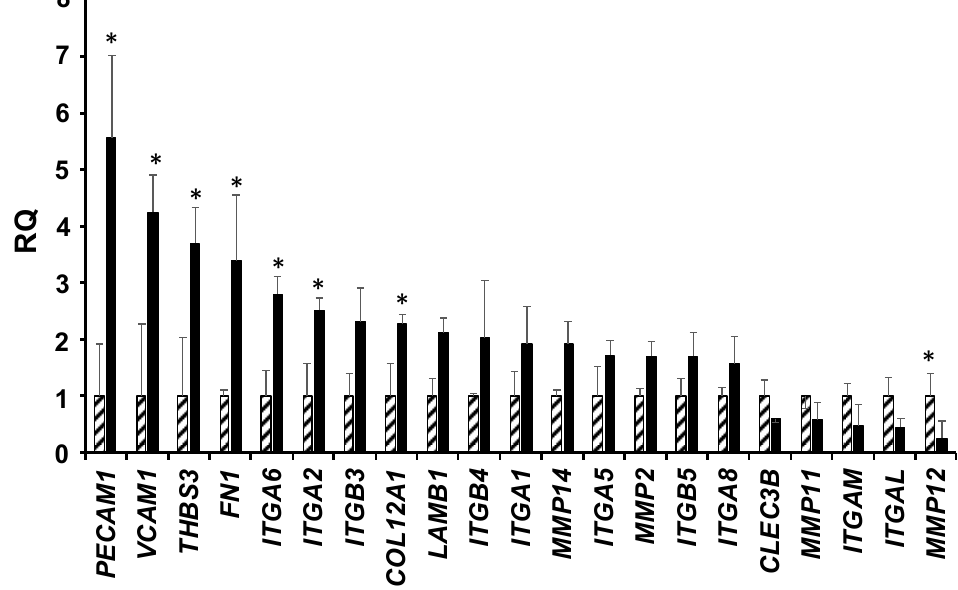
Figure 5. LMNA overexpression increases cell adhesion gene expression. Relative quantification (RQ) of the indicated genes in LMNA + (black) and LMNA -KD (dashed) T98G cells as analysed by qRT-PCR. The data are reported as the level of LMNA + clone mRNA relative to the LMNA -KD clone and are the means + SD (n = 3). Statistical significance: * p ≤ 0.05.